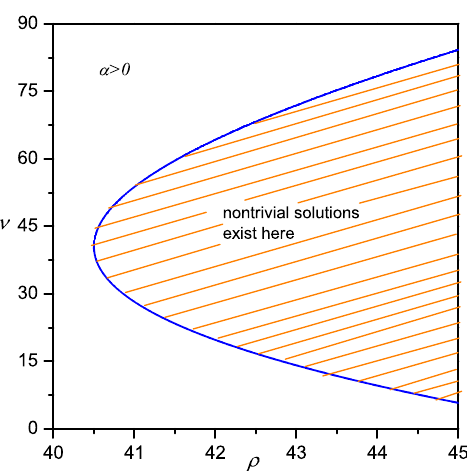
Figure 10. Regions where subharmonic responses exist.